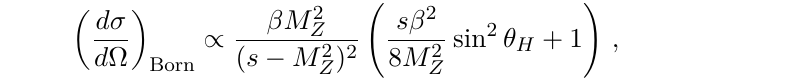
/σ incl − 1 to HZ and ZZ production at the NLO,QED LO √ s